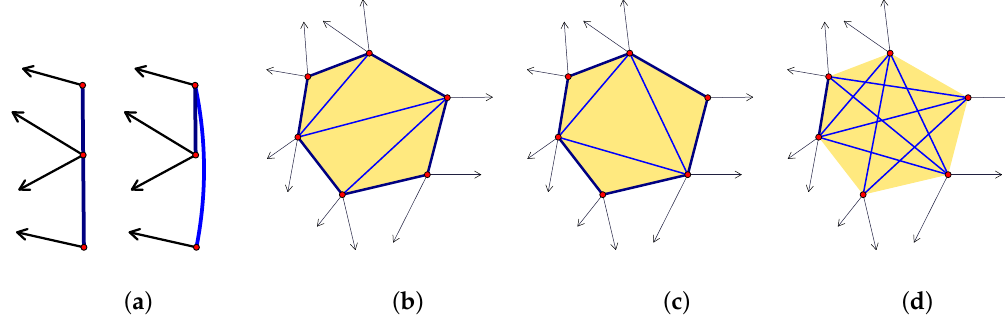
Figure 40. Substituting an isostatic framework on the line with another spanning tree ( a ), or substituting one plane isostatic framework with another one on the same vertices ( b – d ) preserves the static rigidity of the larger